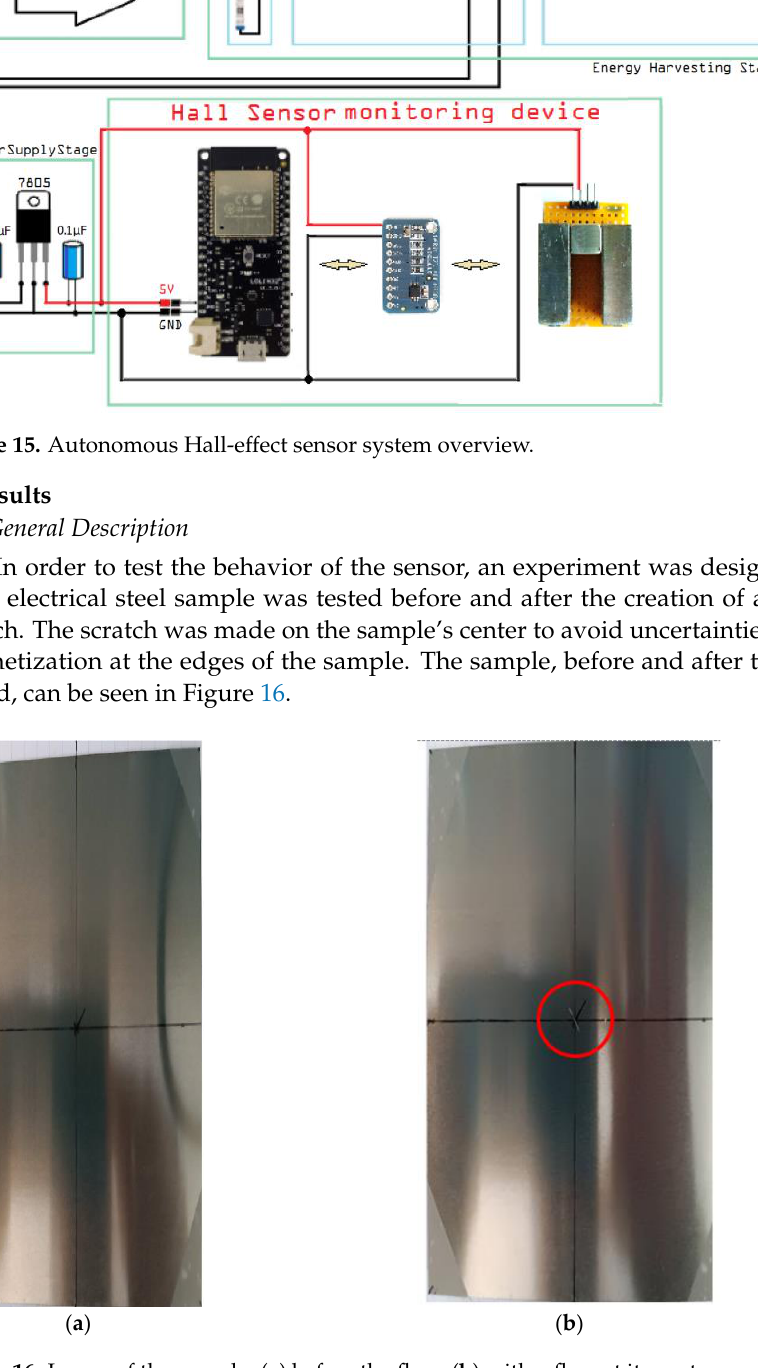
Figure 17. Experimental configuration. By measuring the magnetic flux emanating from the sample at different directions, the magnetic anisotropy profile of the under-test material may be obtained [20]. The term anisotropy is used to explain any preference a material’s property may exhibit, macro- scopically, for a given direction or directions. In the case of magnetic materials, anisotropy reflects the tendency of the magnetization vector to lie along one specific direction [6]. In this particular case, we wanted to test whether or not there was any correlation between the angle of the monitoring device to the sample and the magnetic field measured by the Hall sensor. Measurements were taken every 5 min, each time turning the monitoring device manually by 5 degrees. The axis of rotation was perpendicular to the plane of the sample and passed through its center, as shown in Figure 16. The 5 min were enough to recharge the capacitors of the energy harvester, as predicted. During the measurements, external vibrations were provided by the oscillation generator shown in Figure 8. 3.2. Measurements